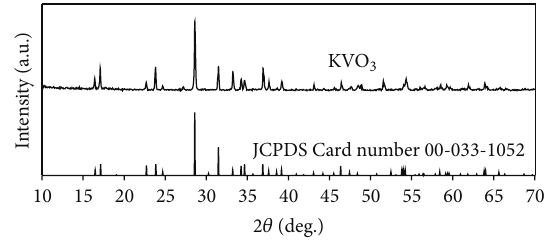
Figure 1: XRD pattern of KVO 3 powder synthesized from K 2 CO 3 andV 2 O 5 viacalcinationinairat457 ∘ C(730K)for5h;thepatternof orthorhombic KVO 3 (JCPDS Card number 00-033-1052) is shown for